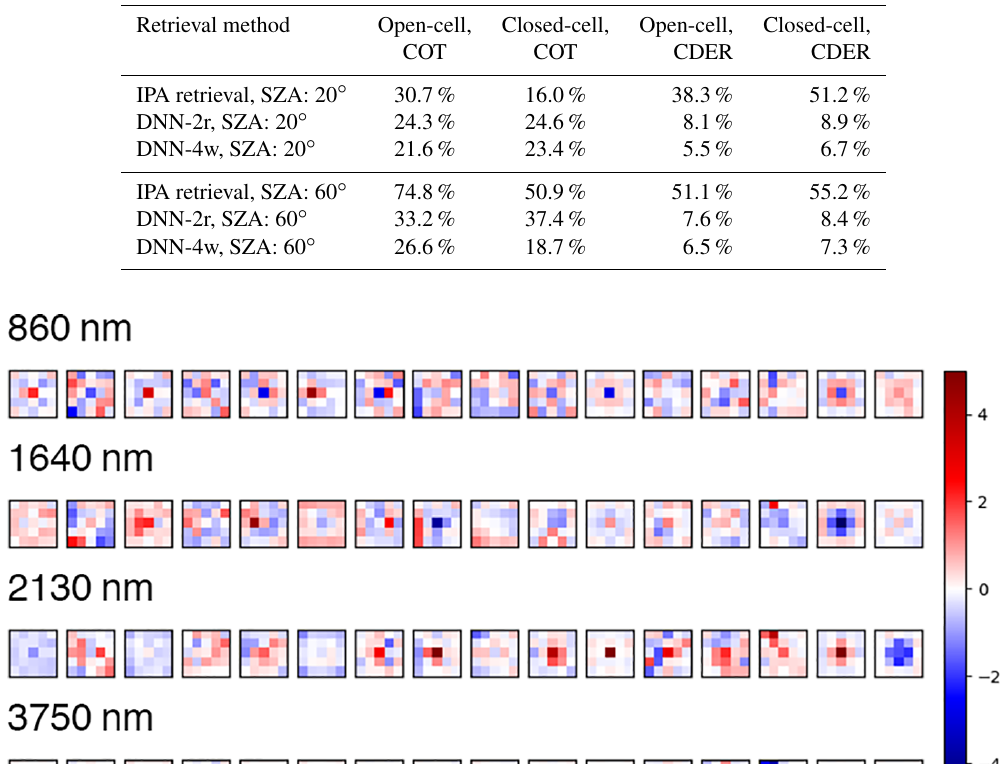
Table 2. The relative RMSE of estimated COT and CDER by the IPA retrieval and DNNs for each cases of cloud field.